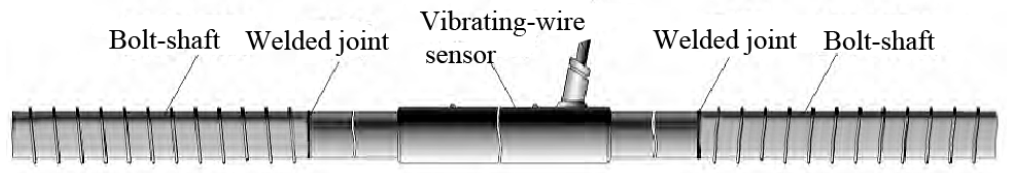
Figure 1. Installation diagram of the vibrating-wire sensor in bolt-shaft.